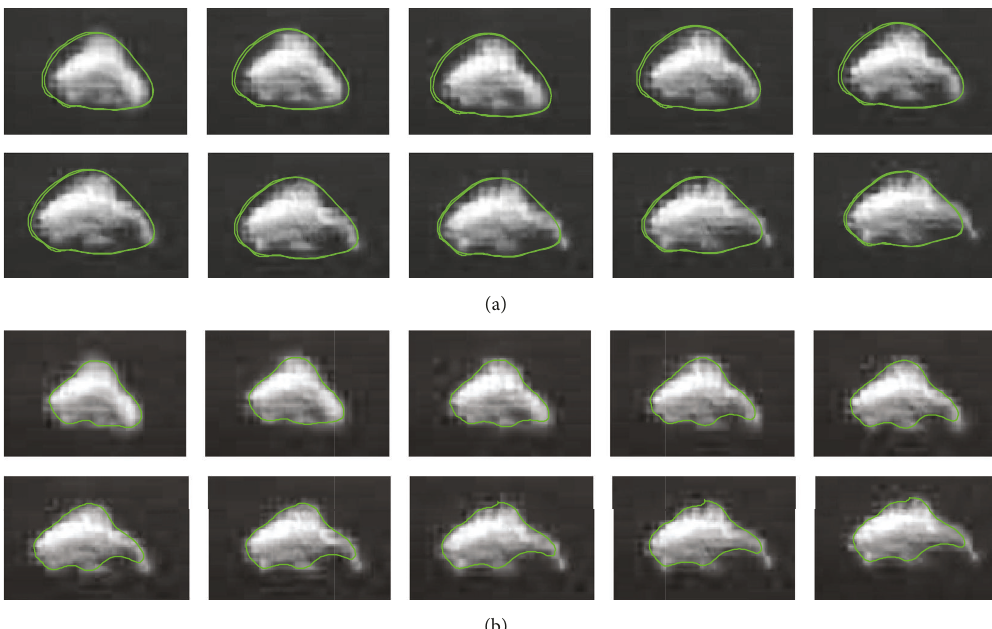
Figure 9: The compared results of segmentation. (a) are the results with the parametric C-V model, and (b) are the results with proposed method.